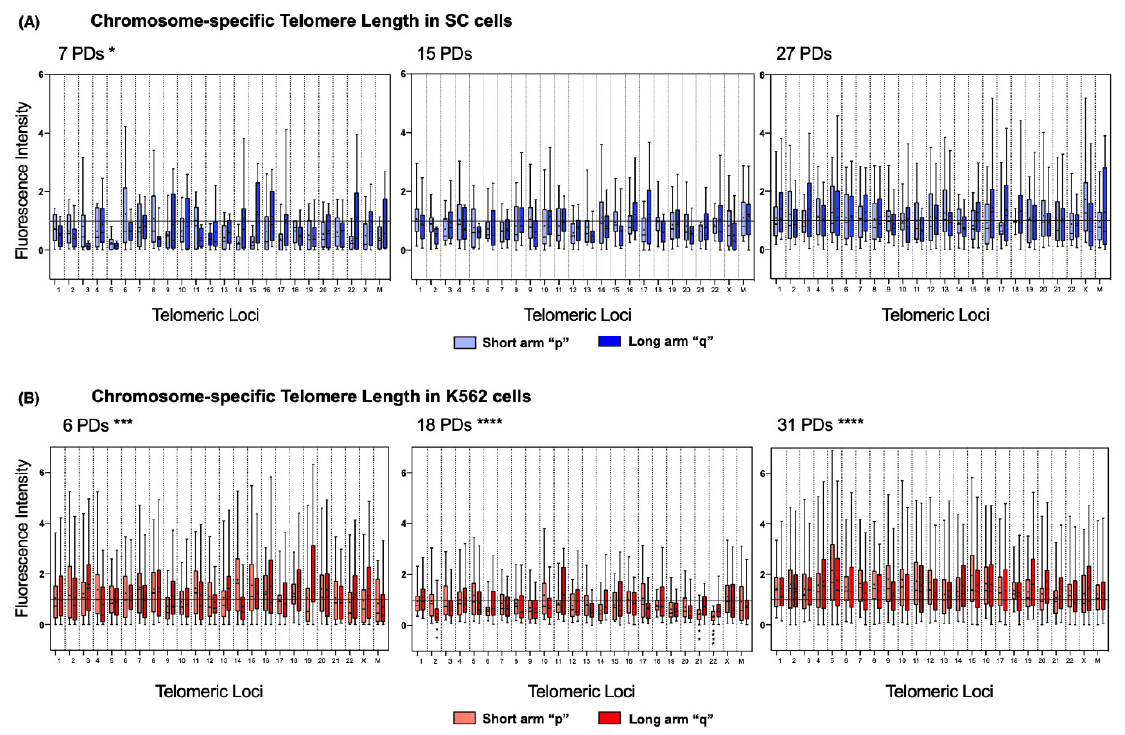
Figure 6. Chromosome-specific telomere length in SC and K562 cells ( A ) In the chromosome arms of the SC cells, we observed steady telomere lengthening. The initial telomere length was significantly heterogeneous at 7 PDs; several chromosome arms displayed critically short telomeres. In later passages, telomere length was recovered, and the dispersion of length values was no longer significant. Data were analyzed using Kruskal–Wallis and Dunn’s multiple comparisons tests. The p value for telomere length at 7 PDs was 0.043 (*). ( B ) In the chromosome arms of the K562 cells, we observed abrupt telomere shortening, followed by heterogeneous lengthening. The initial telomere length was significantly longer than that in the SC cells, but after 18 PDs, the telomere length decreased considerably. Telomeres 2q, 21p, and 22p were significantly shorter after 18 PDs in every analyzed cell. Adjusted p values for telomeres 2q, 21p, and 22p after 18 PDs < 0.005 (**) and <0.0001 (****). After 31 PDs, telomere length recovered, but the dispersion of length values remained statistically significant. Data were analyzed using Kruskal-Wallis and Dunn’s multiple comparisons tests. (A,B) The fluorescence intensity of the telomeric probe was normalized against a centromeric probe and expressed in arbitrary units (AU). The mean value is shown in every box (•). The p value for telomere length at 6 PDs was 0.0002 (***), and after 18 and 31 PDs, it was < 0.0001 (****).